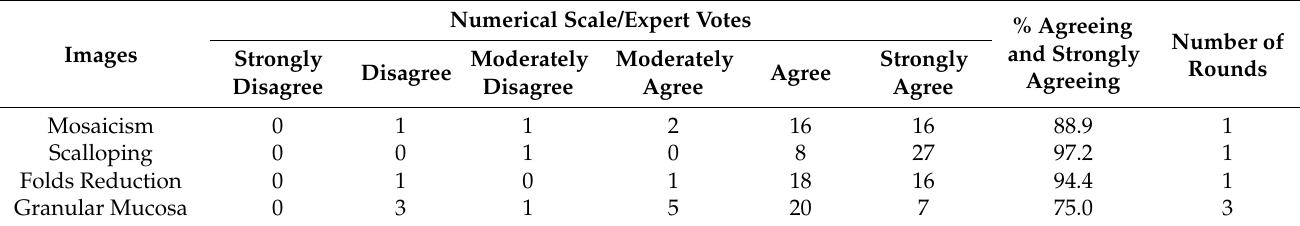
Table 3. Experts group rating on the correspondence between suggested images and core group definition. Consensus was not reached after three rounds for ‘Granular